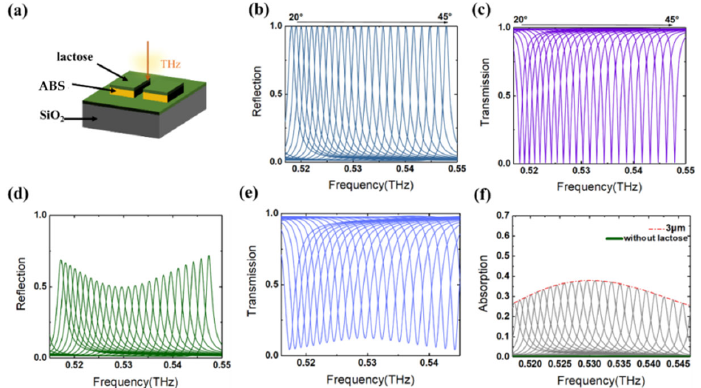
Figure 4. Terahertz absorption spectrum enhancement of the dielectric metasurface without and with α -lactose coatings based on the angle-multiplexing. ( a ) The unit cell structure of the dielectric metasurface coated with α -lactose films; ( b ) reflection and ( c ) transmission of the metasurface without α -lactose coatings; ( d ) reflection and ( e ) transmission of the metasurface coated with 3 µ m α -lactose; ( f ) absorption of the metasurface coated with 3 µ m α -lactose compared with the no-coating